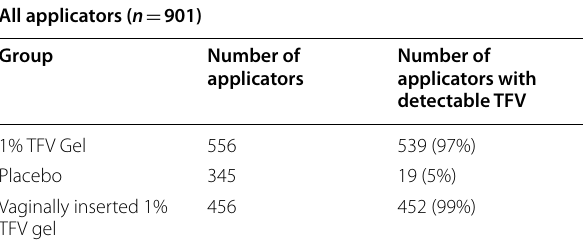
Table 3 Determination of residual TFV on a subset of returned gel applicators